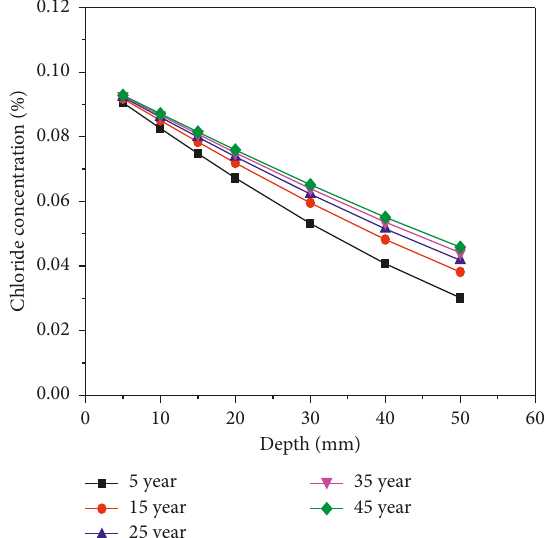
Figure 13: Chloride profile vs. age according to the proposed model (equations (14a) and